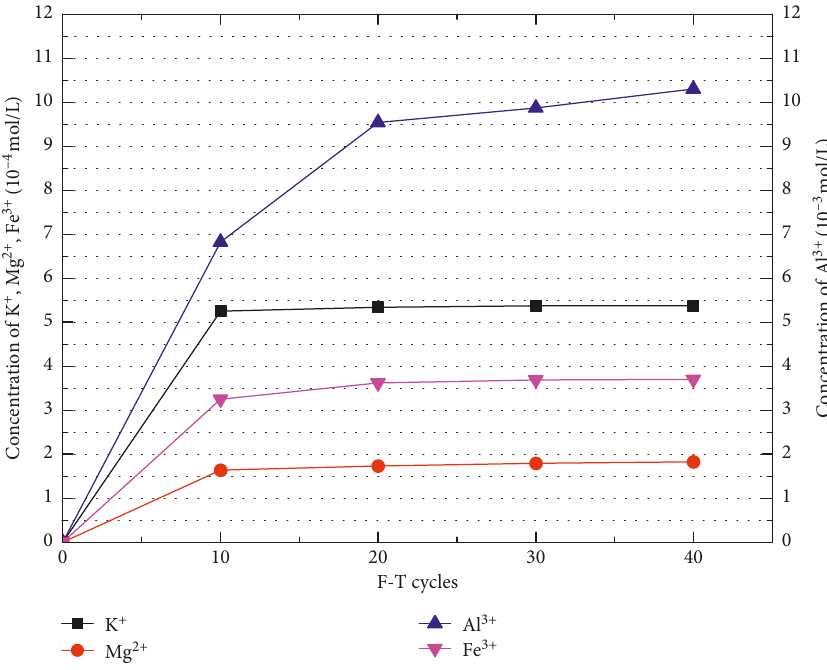
Figure 8: Metallic ion concentrations of solution (pH